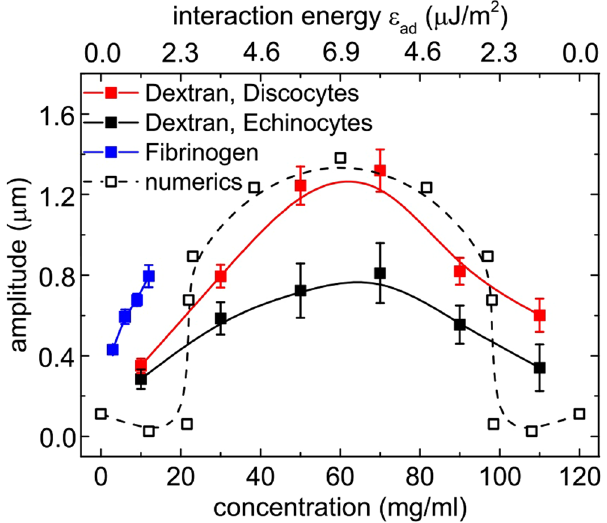
Figure 3. Amplitude of the interfacial deformation for varying concentrations of dextran 70 kDa for discocyte and echinocyte membrane shapes in the experiments and a reduced area of τ = 0.65 in the numerics. For numerical results, an energy scale was chosen by assuming a piece-wise linear variation of the interaction energy with concentration with a maximum of 22.5 μ J/m 2 at 60 mg/ml. Error bars show standard